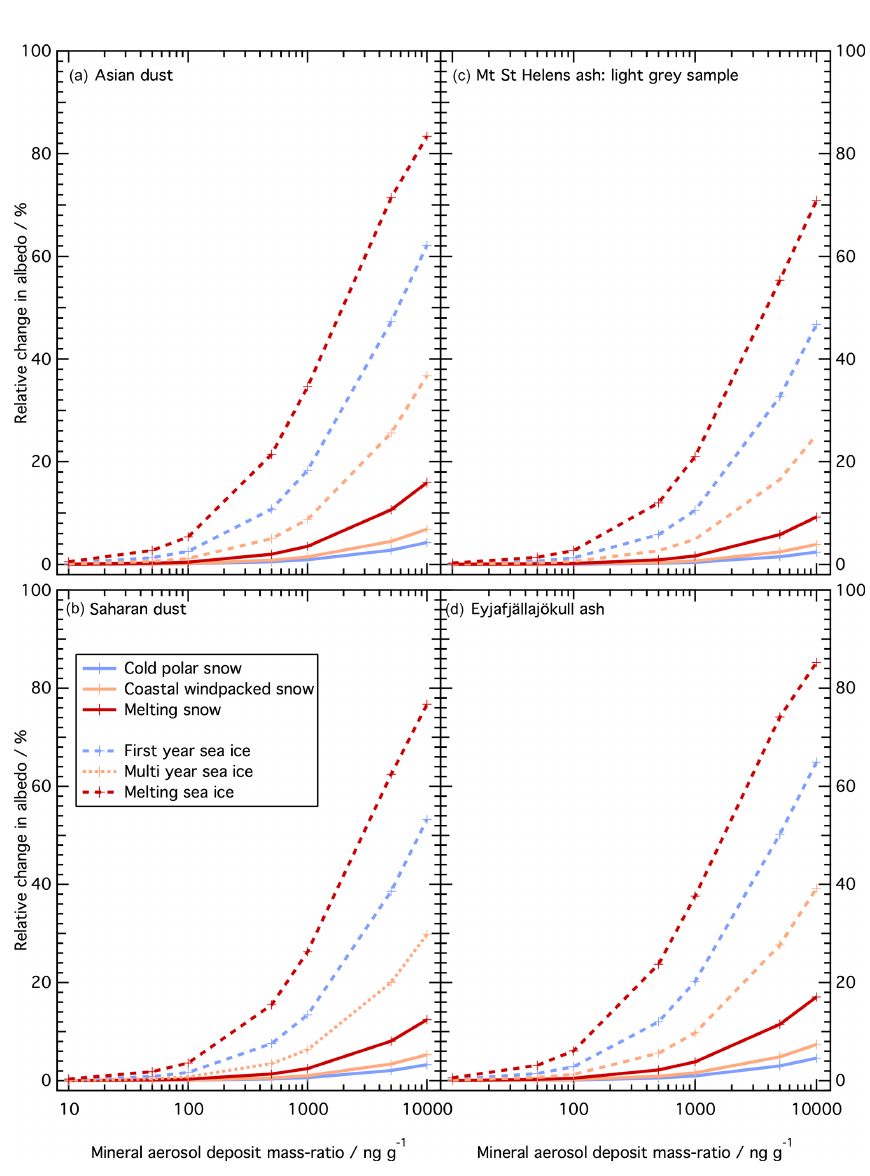
Figure 6. Relative change in albedo at a wavelength of 550nm for an increasing mass ratio of (a) Asian mineral dust (b) Saharan mineral dust (c) Mt. St. Helens volcanic ash (d) Eyjafjällajökull volcanic ash relative to a mass ratio of 1ngg − 1 throughout three semi-infinite snow and sea ice types. The albedo for 1ngg − 1 of mineral aerosol deposits, valid for (a) , (b) , (c) and (d) , is 0.988 for cold polar snow, 0.981 for coastal windpacked snow, 0.953 for melting snow, 0.727 for first-year sea ice, 0.867 for multi-year sea ice and 0.494 for melting sea ice. The values presented for a wavelength of 550nm are indicative of the same behaviour for wavelengths between 400 and 600nm.